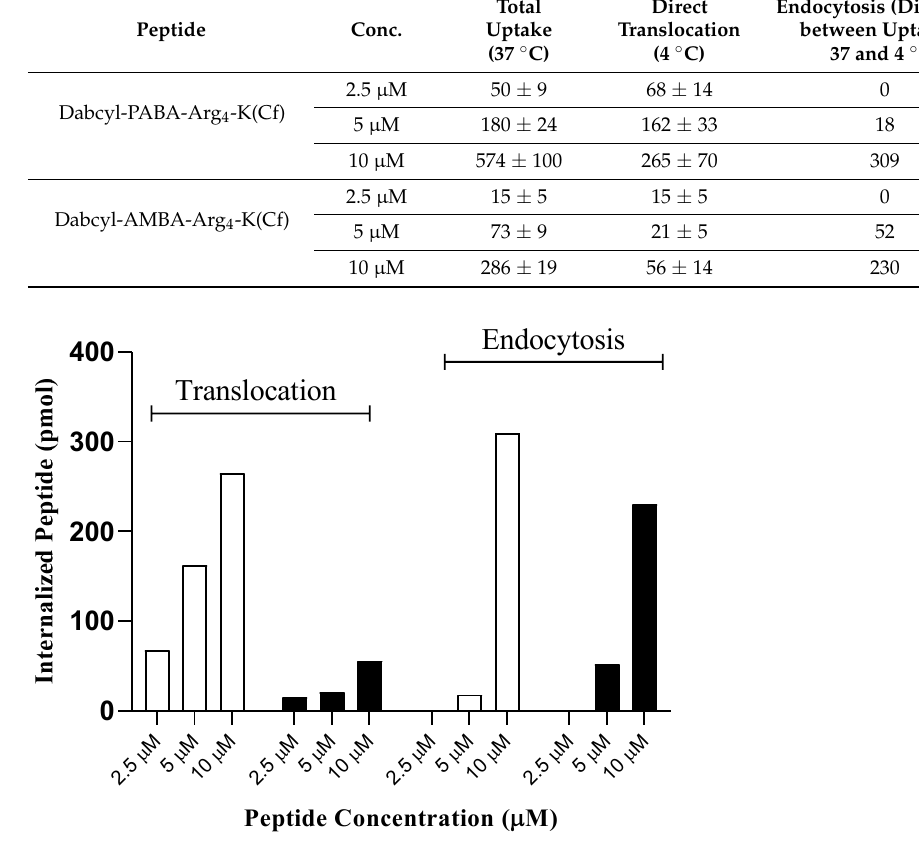
Figure 9. Effect of endocytosis inhibitors on the cellular uptake of peptide conjugates. MDA-MB-231 cells were pretreated with NaN 3 (10 mM) and DOG (5 mM) for 30 min, the cells were then treated with the peptide conjugates (5 µ M) for 90 min. Significant difference from control was measured using Student’s t test (* p < 0.05 and ** p < 0.01). Table 2. Quantification of the extent of different internalization pathways in CHO cells (at 2.5, 5 and 10 µM). Values refer to the average amount of internalized peptide in pmoles. For each condition, experiments have been repeated independently at least 3 times. Peptide Conc.